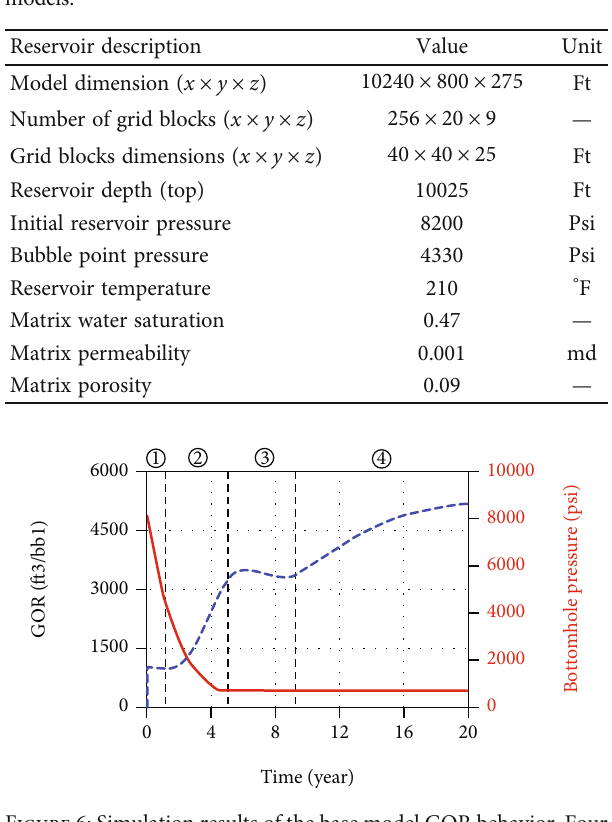
Table 1: Basic reservoir properties used in the fi eld-scale shale-gas models.